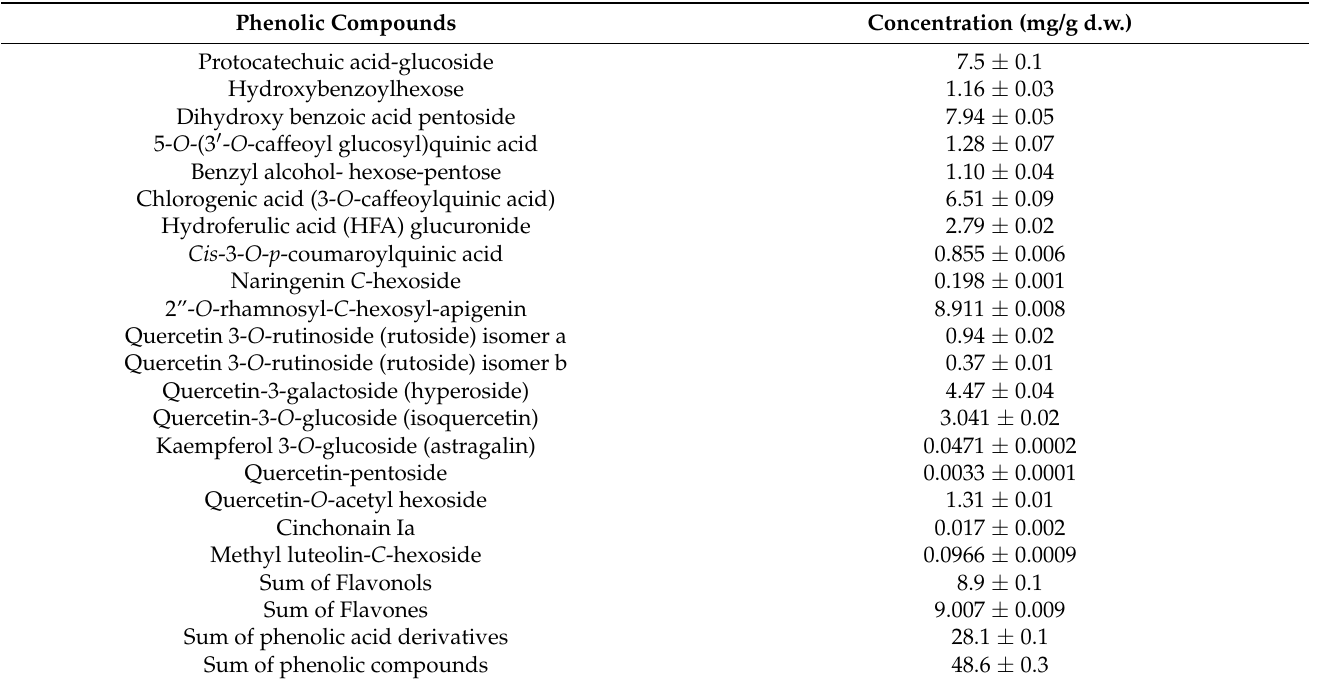
Table 5. Table of quantification of phenolic compounds from C. monogyna optimum leaf extract by HPLC-MS expressed as mg · g − 1